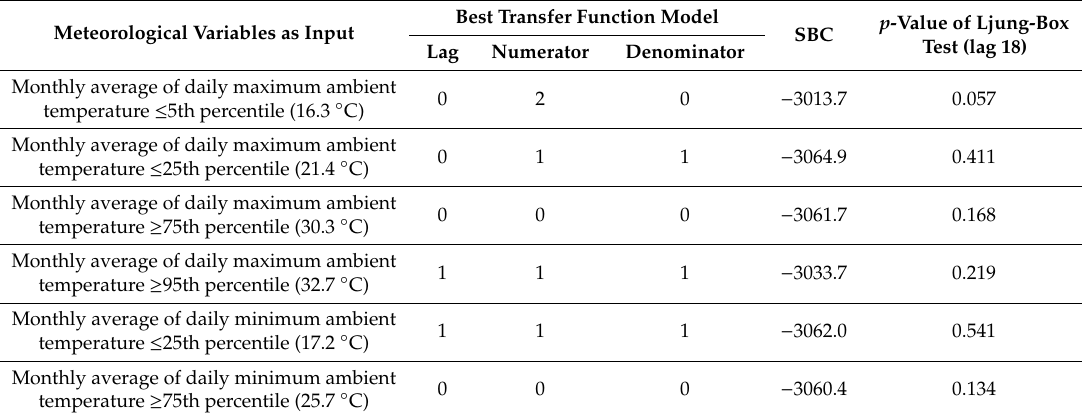
Table A3. Transfer function models for the rate of older-adult suicide deaths from violent methods (Sensitivity Analysis).